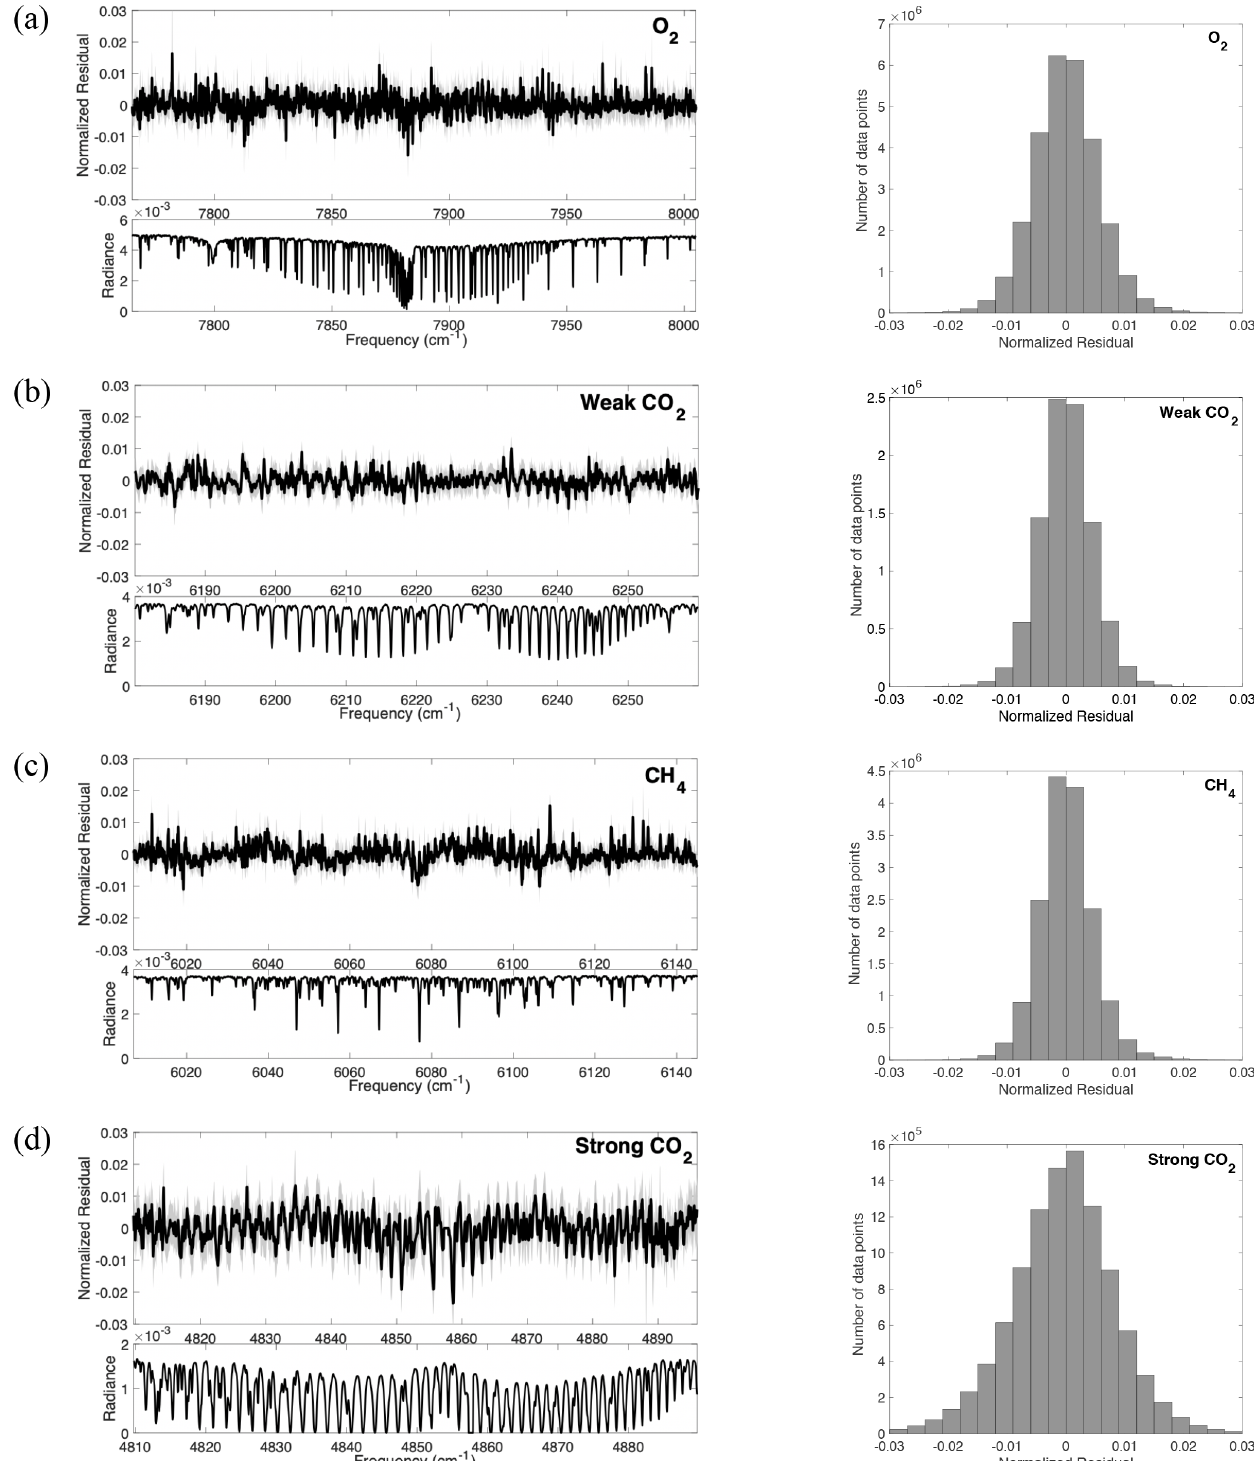
Figure 13. (a) Upper left: median fitting residual (black) and ± 1 σ range (grey) for the O 2 band. Lower left: sample measured spectrum. Right: histogram of fitting residuals. Panels (b–d) are the same as (a) but for the weak CO 2 band, the CH 4 band, and the strong CO 2 band,